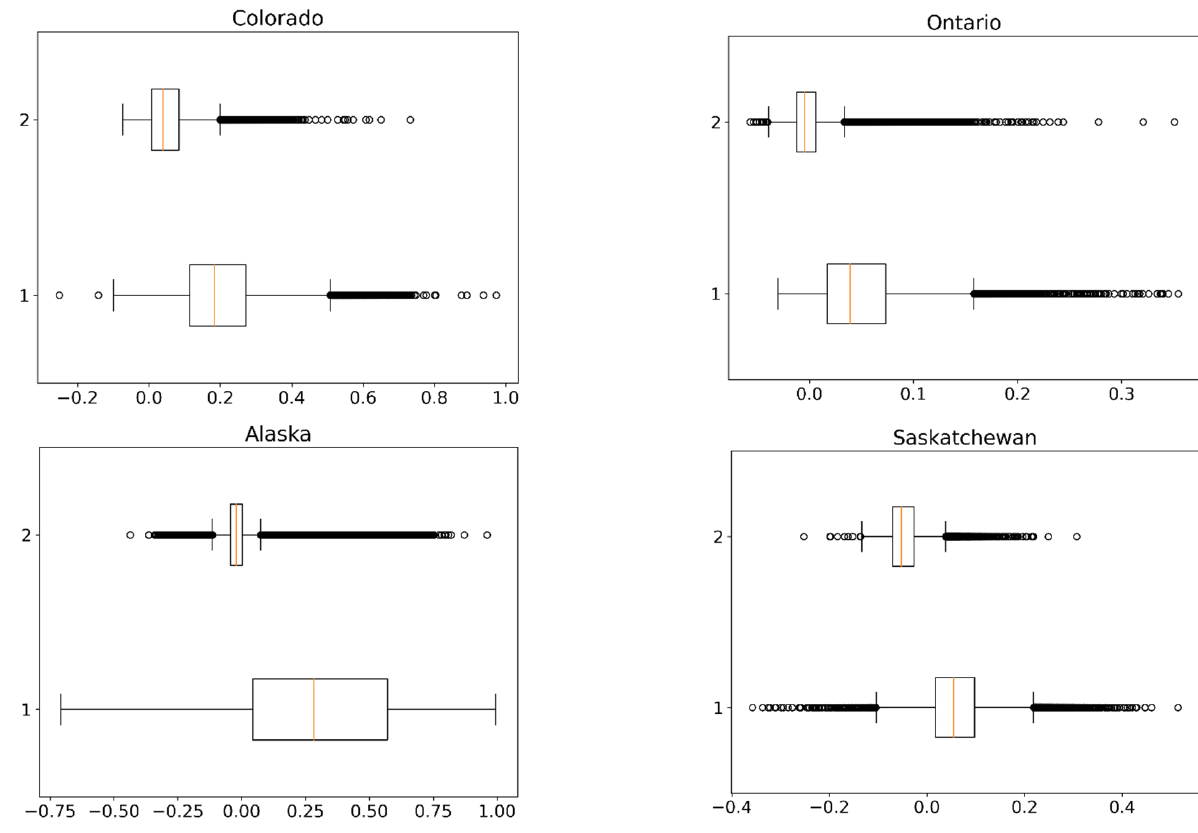
Figure 3 . Boxplots of NDVI values per case study area. NDVI values for true positives (2) and false negatives (1).